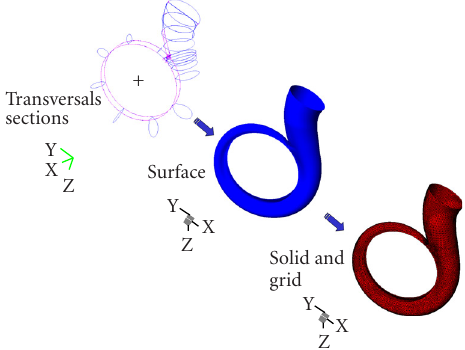
Figure 10: Grid generation steps of pump-volute casing NS32.